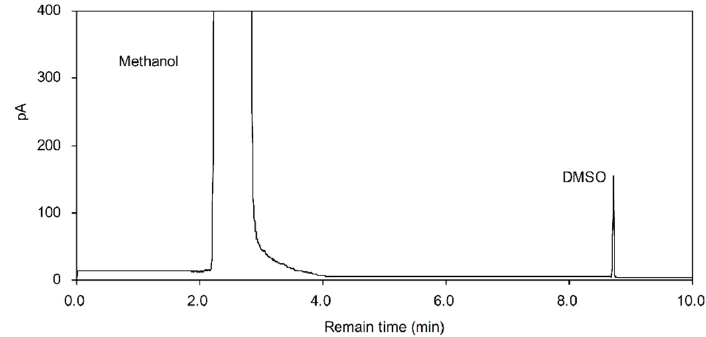
Figure 8. Gas chromatograms of spiramycin microparticles, indicating the presence of residual DMSO (spiramycin microparticles are the micronized spiramycin by the homogenate-antisolvent precipitation under optimum conditions).